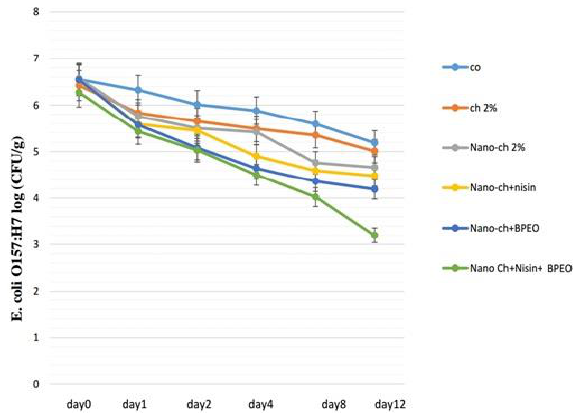
Fig. 4: Effect of the treatments on the growth of E. coli O 157 :H 7 during storage.